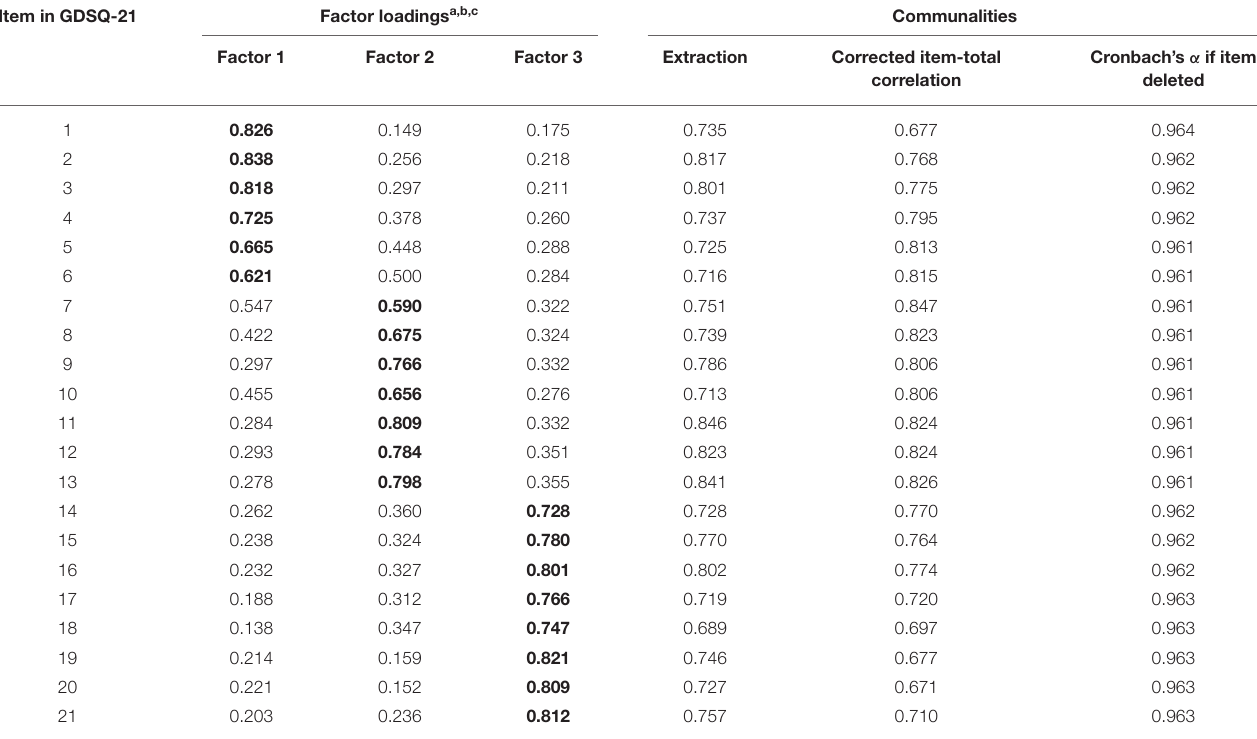
TABLE 3 | Summary of the results from the EFA on the GDSQ-21 items obtained from the sample ( n = 3,871). Item in